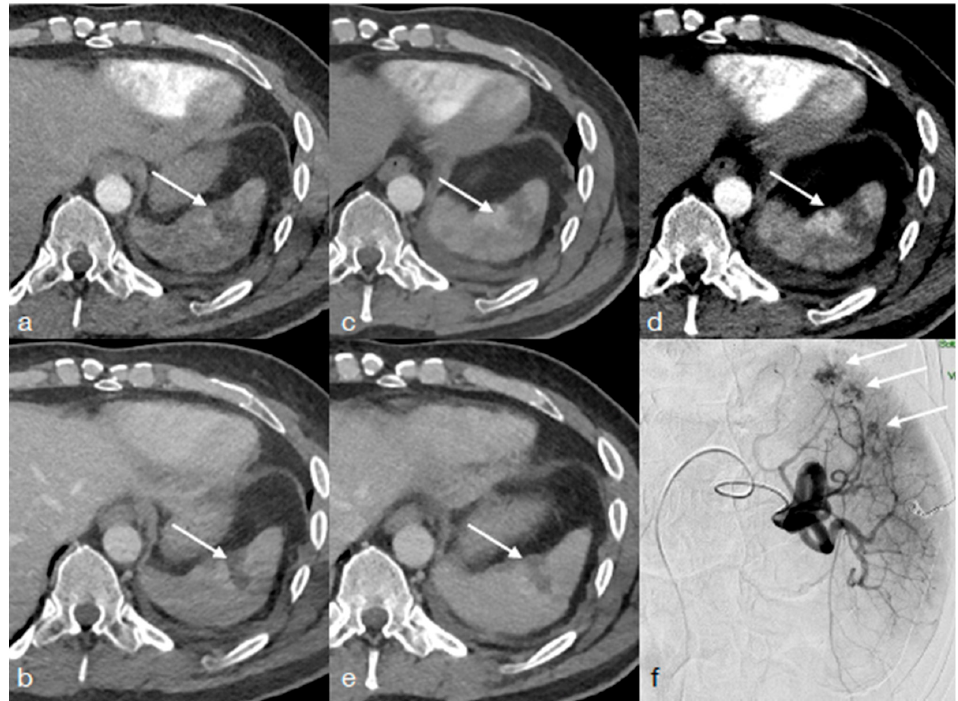
Figure 2. A twenty-seven year-old male underwent high-energy trauma. Enhanced CT performed upon admission in arterial ( a ) and portal phase ( b ) shows a spleen laceration (( a , b ) arrows). The first follow-up CT, performed 24 h later ( c – e ), was acquired with dual-energy technique (( c ) arterial phase, ( d ) low KeV arterial phase and ( e ) portal phase). Note the better visualization of the contained vascular injuries in ( d ) (arrow), in comparison with (( c ), arrow) adjacent to the laceration ( e , arrow). CT fi ndings were con fi rmed at angiography (( f ), arrows) and then, treated. In the se tt ing of the non-operative management of polytraumatized patients who un-